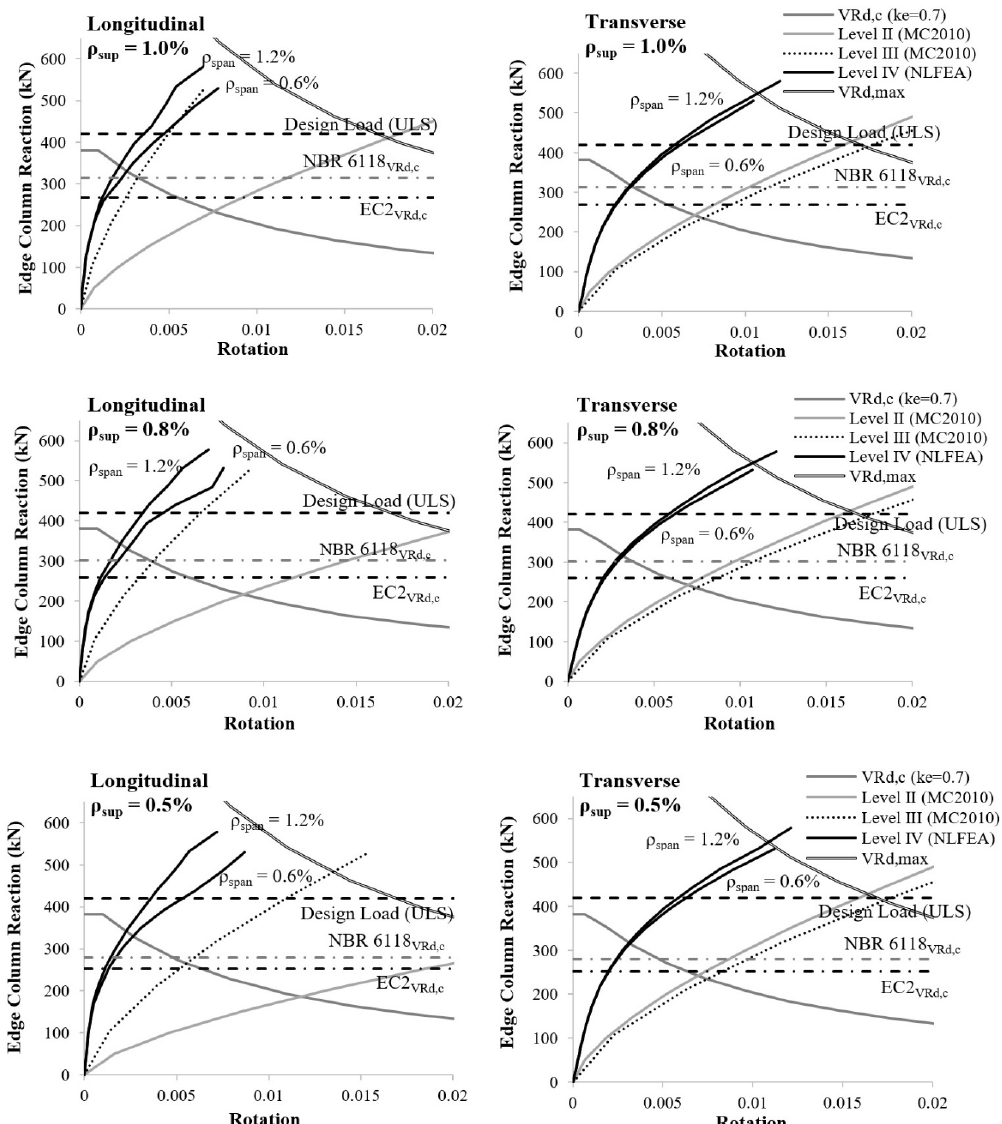
Figure 16. Longitudinal and Transverse rotations of the subassembly slabs from the parametric study. Note: Slabs with ρ span = 0.3% didn’t reach the design load as would likely fail in flexure, therefore they are not shown in the